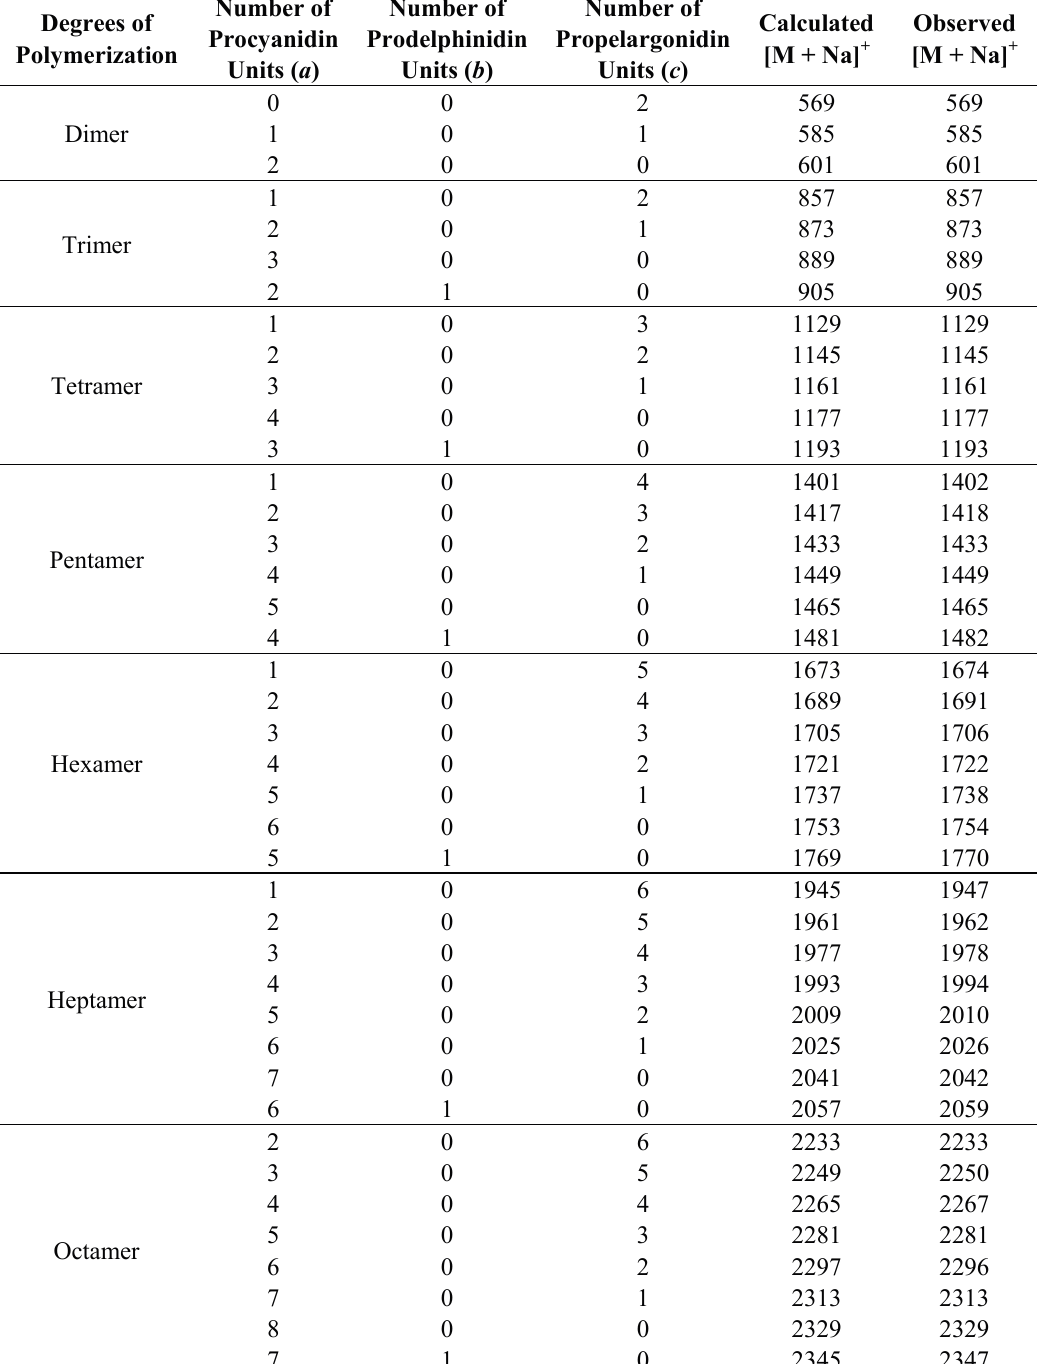
Table 1. Observed and calculated masses for Cecropia sciadophylla proanthocyanidins extracted from immature leaves. Mass calculations were based on the equation 288 a + 304 b + 272 c + 2 + 23, where a is the number of procyanidin units, b is the number of prodelphinidin units, and c is the number of propelargonidin units, 2 corresponds to the number of extra hydrogens on the terminal subunits and 23 is the atomic mass of